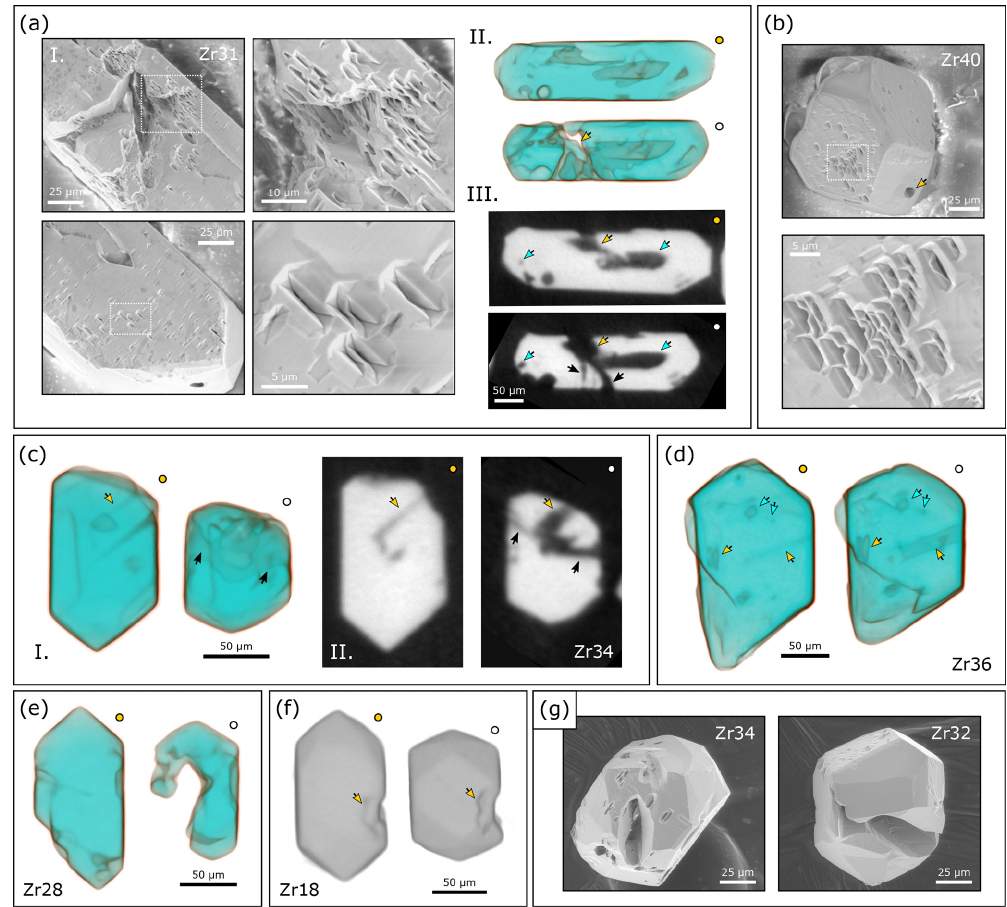
Figure 17. SE and µCT images of BOM2A grains pre- and post-chemical abrasion at 210 ◦ C for 12h. (a) Subpanel (I) shows SE images of Zr31, showing deep fractures penetrating the grain’s interior. Close-up images showing well-faceted etch pits on (100), some of which are isolated, while others are interconnected. The long axes of deep, octahedral etch pits are oriented parallel to the c axis, whereas the long axes of shallower etch pits are oriented parallel to the a axis. (II) Semi-transparent 3D rendering of µCT data again highlighting the development of large fractures. (III) 2D µCT image slices. Teal arrows highlight inclusions that were dissolved; the yellow arrow points to a surface- reaching inclusion that acted as an acid path into the grain interior, and the black arrow highlights acid paths not observed in the before imagery dataset. (b) SE images of Zr40 that demonstrate how some crystallographic faces are strongly etched, while others are pristine. Etch pits are again strongly prismatic and sometimes interconnected. The yellow arrow points to a void where there was once an inclusion. (c) Subpanel (I) shows a semi-transparent 3D rendering of µCT data for Zr34, showing a significant shortening of the crystal’s c axis. (II) 2D µCT image slices. The yellow arrows highlight surface-reaching inclusions removed by partial dissolution. Black arrows mark acid paths not apparent in the before imagery dataset. (d) Semi-transparent 3D rendering of µCT data for Zr36. Teal arrows highlight inclusions inferred to have survived partial dissolution. Yellow arrows highlight inclusions that were dissolved. (e) Semi-transparent 3D rendering of µCT data for Zr28, showing significant volume loss from the grain interior. (f) Opaque 3D rendering of µCT data for Zr18. Yellow arrows highlight how some topographic features are preserved during partial dissolution despite significant volume loss. Note how crystal facets are better developed after partial dissolution. (g) Low-magnification SE images of Zr34 and Zr32 showcasing the crystallographic dependence of surface etching and acid paths that cut deep into grain